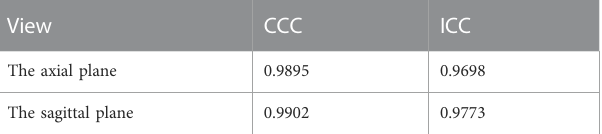
TABLE 3 Results of statistical analysis of the concordance correlation coef fi cient (CCC) and the intraclass correlation coef fi cient (ICC) between the results measured by the proposed automated method and the manually measured